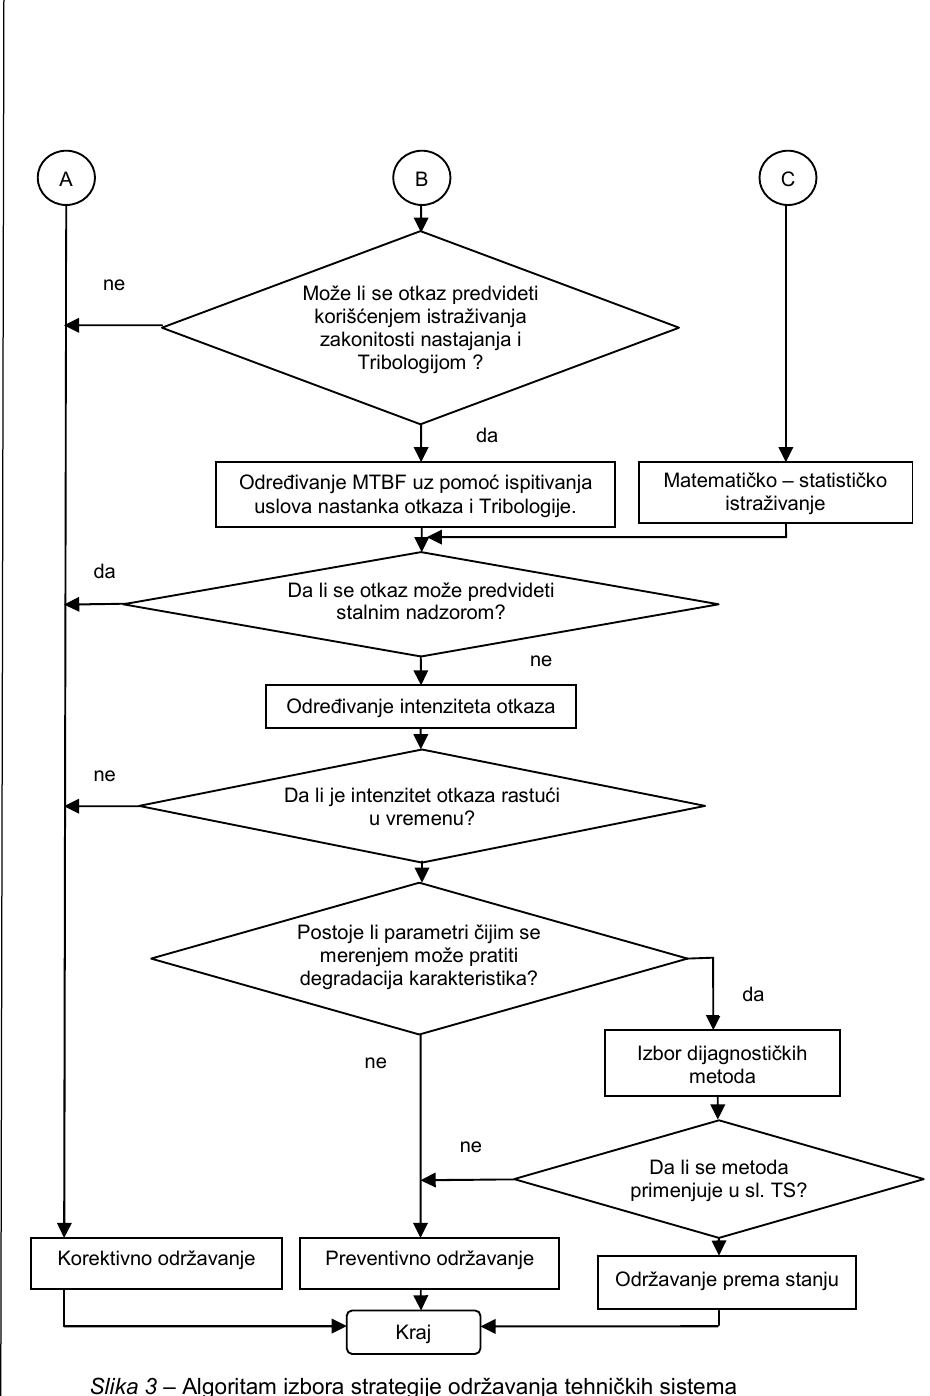
Figure 3 – Algorithm for selecting a technical system maintenance